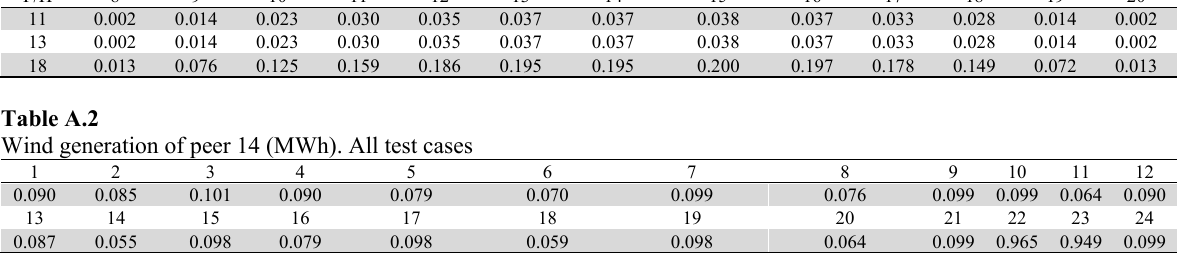
PV generation of peers 11, 13, and 18 (MWh). All test cases P/H 8